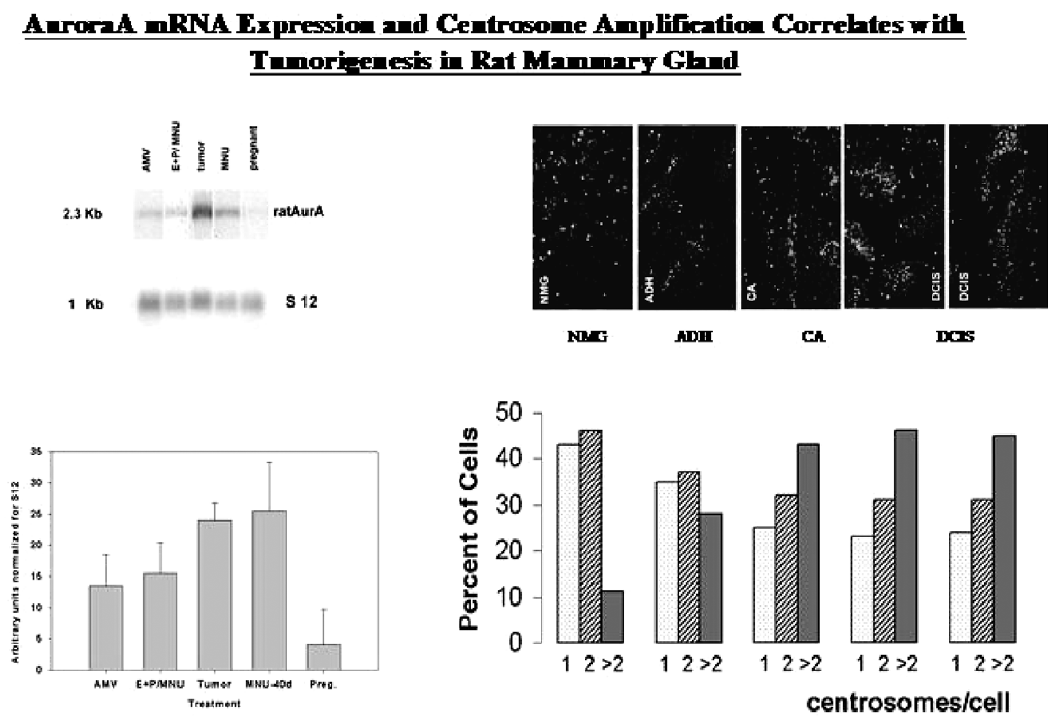
Fig. 2. Northern blot containing Poly A + RNA (5 µ g) from rat mammary gland tissue representing different regimens with graph of arbitrary units (see [10]). Insets in upper right show confocal microscope images of centrosomes localization in rat mammary glands of normal (NMG), atypical ductal hyperplasia (ADH), mammary carcinoma (CA) and ductal carcinoma in situ (DCIS). Centrosome profiles for each of these stages are also shown. Cells with > 2 centrosome/cell represent centrosome amplification (reproduced from Brinkley et al., in Hormonal Carcinogenesis, Li and Li, eds, Springer-Verlag (in